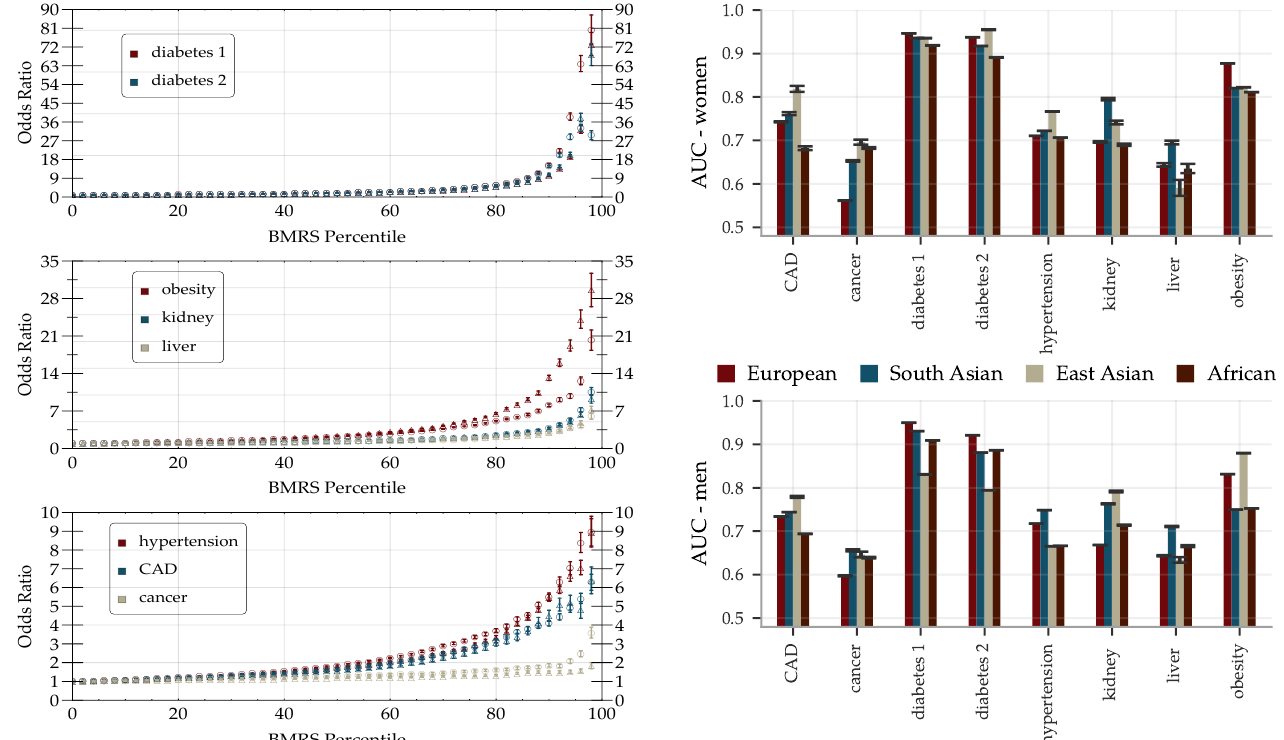
Figure 6. The predictive power of BMRS can single out high risk individuals with over 10 × odds ratio for many traits, and AUCs > 0.7 for most traits including tests across ancestry. ( Left ): inclusive odds ratio (OR) plots for diabetes type 1/2, obesity, kidney problem, liver problem, hypertension, CAD, and any cancer trained and validated on the European population. Horizontal axis indicates individuals at that percentile and above in PRS. Marker is for predictors trained and validated on men and marker (cid:52) for predictors trained and validated on women. Error bars represent the standard error of the mean value with a contribution coming from computing the OR and a contribution from including 5 predictors. ( Right ): AUCs for BMRS predictors separately trained on men and women. All predictors are trained on the European population and then validated on European, South Asian, East Asian, and African populations. The error bars indicate the standard deviations for 5 different predictors and do not reflect the significant uncertainties arising from limited available statistics (sample sizes are listed in Supplementary